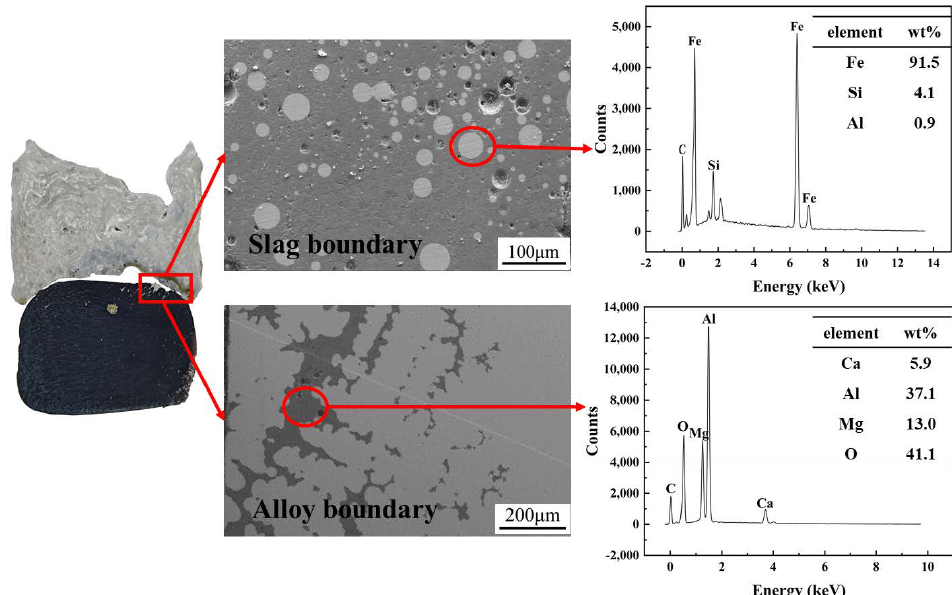
Figure 9. Interfacial morphology and dotting analysis at 10 min between Fe-5Al alloy and low SiO 2 slag. The change of the interfacial area accompanying the spontaneous emulsification is shown in Figure 10. The interfacial area increases quickly to the maximum value and then decreases. Compared with the interfacial area change shown in Figure 6 for the sample constituted of Fe-5Al alloy and high SiO 2 flux, there are two distinctions. The first is the fragment of the increasing of the interfacial area was observed, the second is that the value of the maximum interfacial area is just about half of that shown in Figure 6. These two distinctions indicate that even though the dynamic interfacial phenomena and spontaneous emulsification still exist apparently, the intensity and the extent of spontaneous emulsification was weakened due to the decrease of the reaction affinity between the metal and the slag.